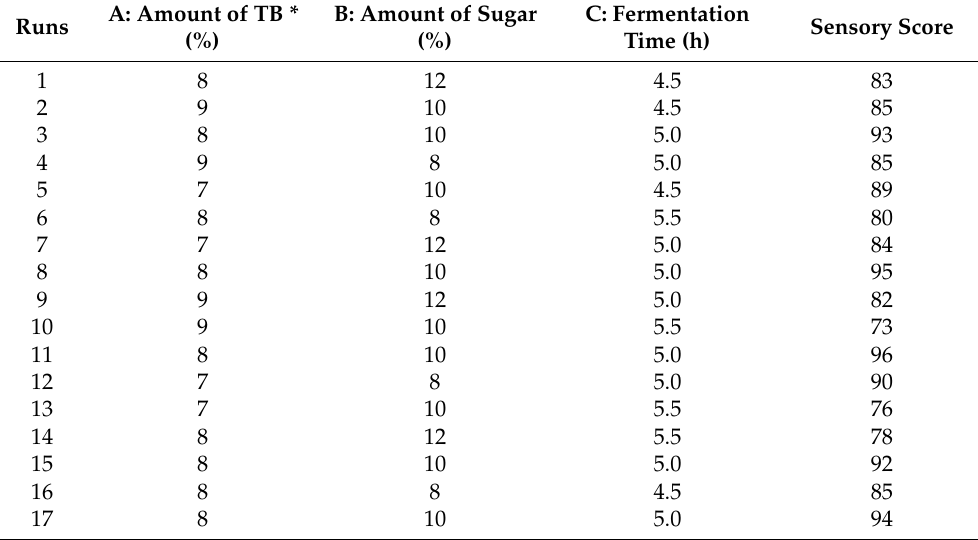
Table 1. Box-Behnken design matrix with experimental runs and observed responses.